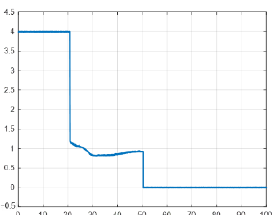
Figure 1. Schematic diagram of the ESC experimental setup based on AE. The collected raw voltage, current, acoustic, and temperature signals are shown in Figure 2. The time range of the short-circuit occurrence can be clearly defined by the fluc- tuating region of the voltage change. The voltage has the remarkable characteristics of initial sag, fluctuation retention, and secondary sag. The corresponding current has a sim- ilar change process of the initial jump, mid-wave, and terminal drop, which is a phenom- enon that can be clearly distinguished from the short-circuit condition at the electrode measurement. Corresponding to the temperature signal, the initial occurrence of the short circuit could obtain the rise of the temperature for the positive and negative electrodes and the slight decrease of the temperature after the short circuit is completed. Correspond- ing to the acoustic signal, the initial signal observation would roughly distinguish be- tween the beginning and the end of the short circuit (compared to the range determined by the voltage or current); the signal has an initial apparent change (at the beginning of the ESC), and a relatively weak mutation (at the end of the ESC); other acoustic features are not very obvious; it is difficult to distinguish from the data on the figure.